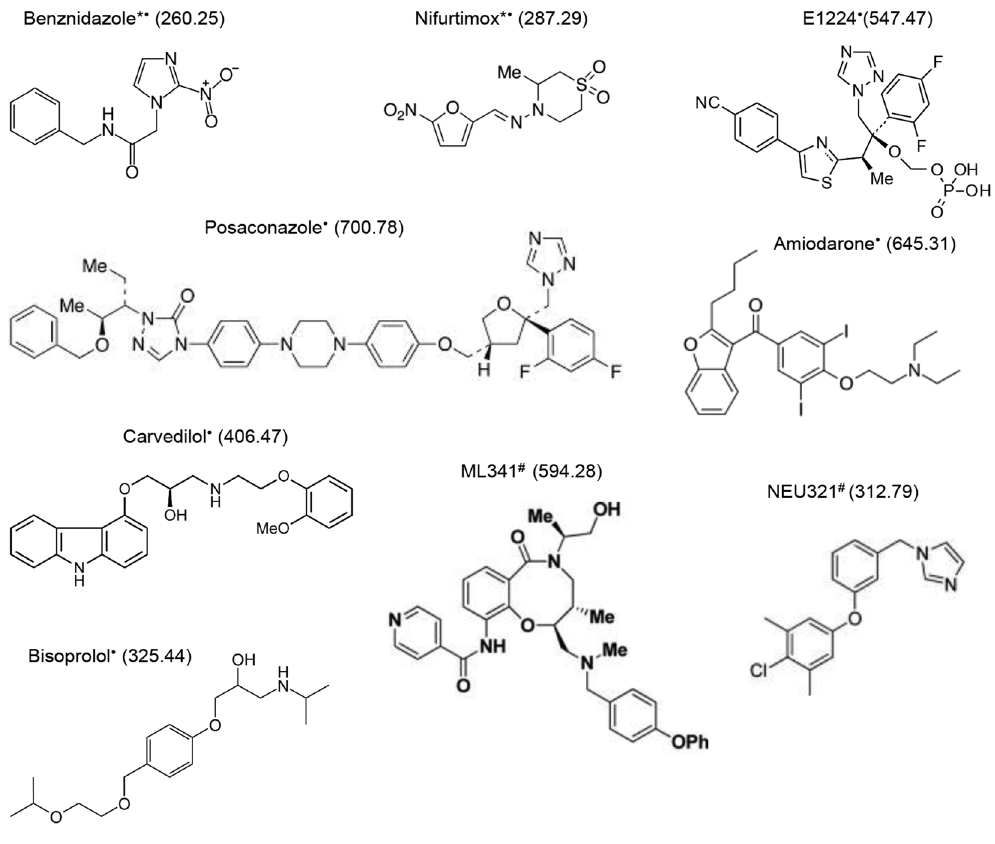
N Figure 1. Anti– Trypanosomacruzi compounds. Chemical structures of anti– T. cruzi compounds currently in clinical use (*) and currently or ), and of the most promising compounds retrieved out of the Broad Institute HTS campaign [44] and the screening of a recently in clinical trials ( smaller, diversity-oriented chemical library [39,43] ( # ).